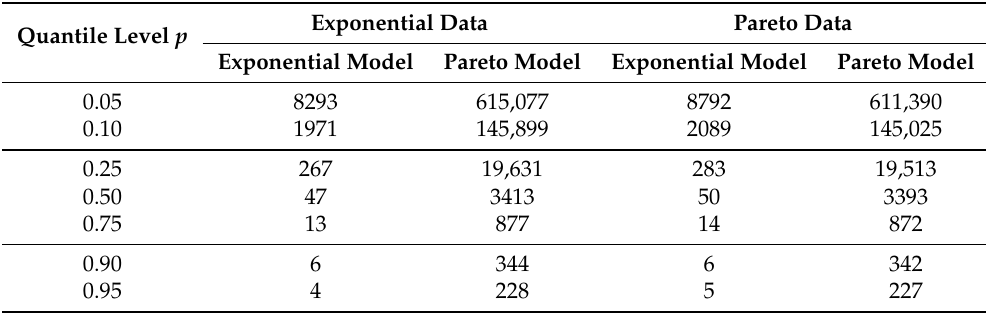
Table 4. Estimated Pareto and exponential RECs (MLE and empirical) at selected quantile levels. Model parameter estimates are from Table 2, based on the data of Table